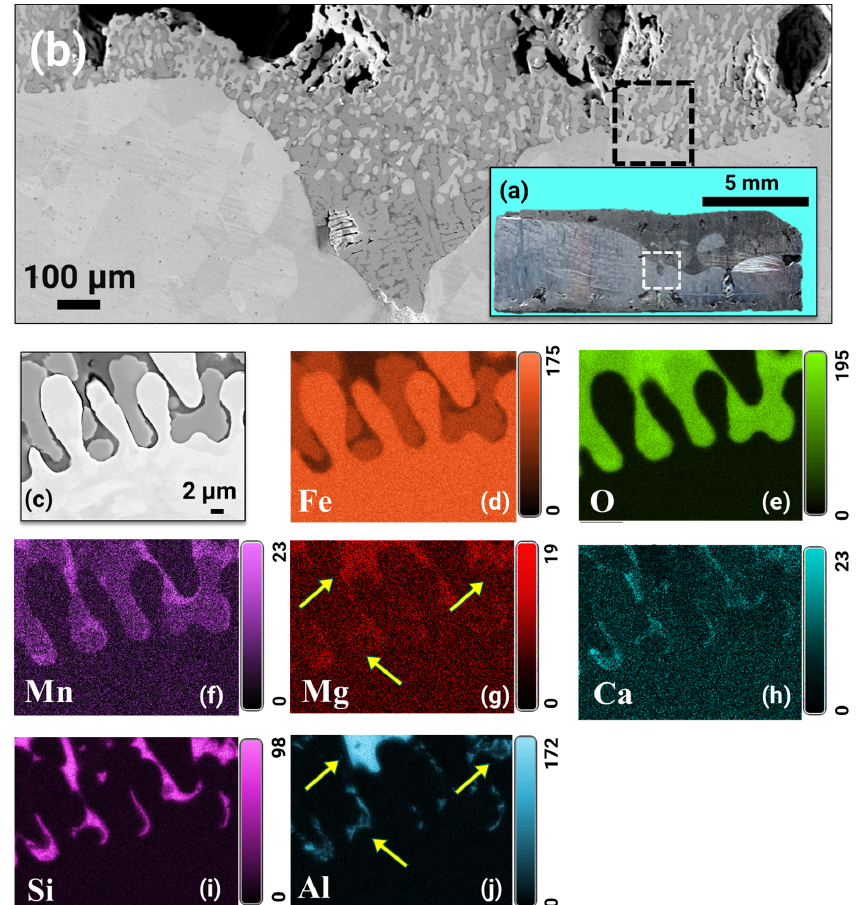
Figure 9. Microstructural characterization of the reduced and smelted Carajas ore sample (C1): ( a ) an overview of the cross section of the solidified sample. The red frame in this figure highlights the area chosen for microstructural inspection. ( b ) SE image of the area indicated by the red frame in ( a ), revealing details of the microstructure of the domains near the interface between iron and unreduced oxides. ( c ) Enlarged view of the area delimited by the frame in ( b ), displaying details of the interface between iron and unreduced oxides. The corresponding local chemistry is given in the form of elemental distribution maps for ( d ) Fe, ( e ) O, ( f ) Mn, ( g ) Mg, ( h ) Ca, ( i ) Si and ( j ) Al. Figure 10a shows an overview of the EC sample reduced and smelted via hydrogen plasma. The yellow frame in this figure highlights the region selected for analysis via SEM, and the corresponding microstructure is depicted in Figure 10b. This figure suggests that, similarly to the C1 sample, there is a pronounced slag–metal separation. Figure 10c shows the microstructure of the solidified domains around the slag–metal interface. The local chemistry was determined using EDX, and the corresponding elemental distribution maps are shown in Figure 10d–j. The yellow arrows in the figure show that iron oxides are doped with Mn (Figure 10i) and Mg (Figure 10j) but devoid of other elements. The oxides enriched in Ca, Si, and Al combine in varying amounts to form complex constitu- ents. To clearly distinguish these regions, yellow dotted lines have been drawn around them, as shown in Figure 10f,g,h, respectively. As well as being present in these regions, Ca oxides can also exist independently, i.e., without mixing with any other slag